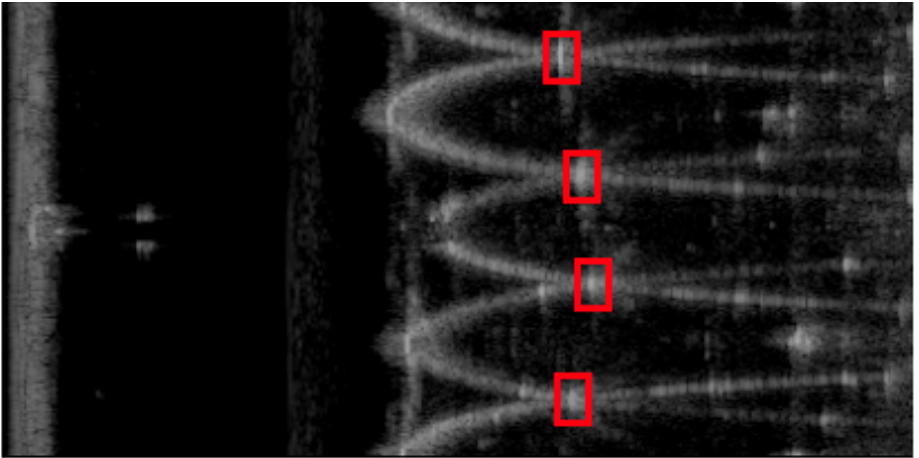
Figure 4. An example of corner-like structures’ acoustic image representation (highlighted in